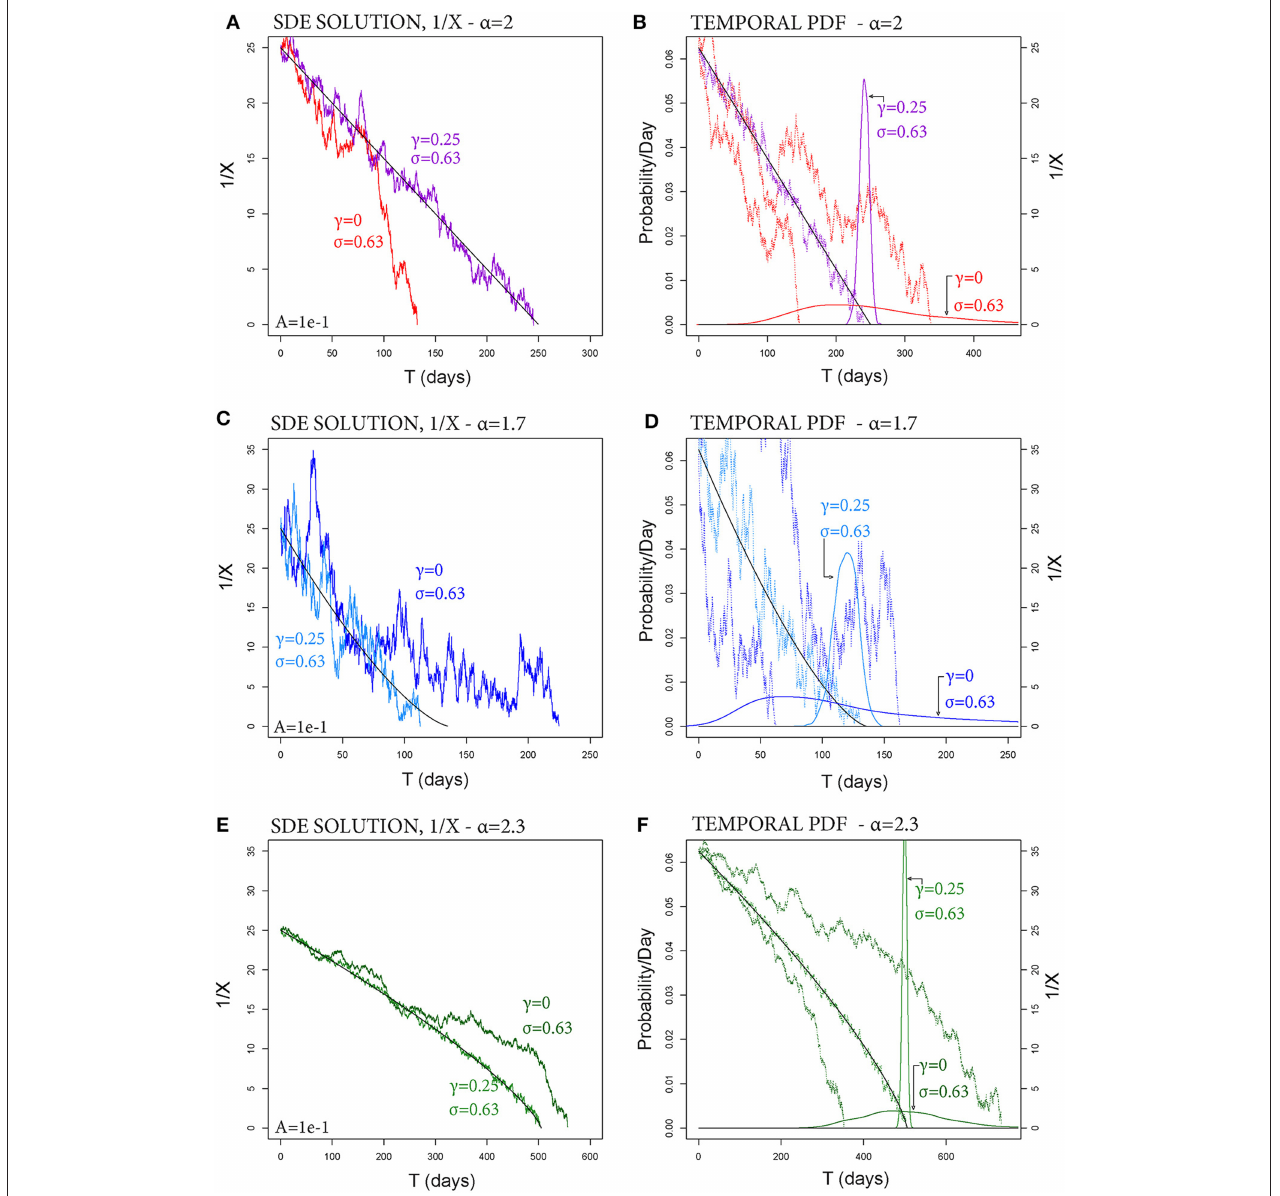
FIGURE 2 | Examples of SDE solutions of FFM, 1 / X , (A,B) with α = 2, (C,D) with α = 1.7, (E,F) with α = 2.3. A black line marks the mean solution. In (A,C,E) the colored lines are random paths, with γ = 0 or γ = 0.25. In (B,D,F) the colored continuous lines are the pdfs of t f , and random paths are dotted